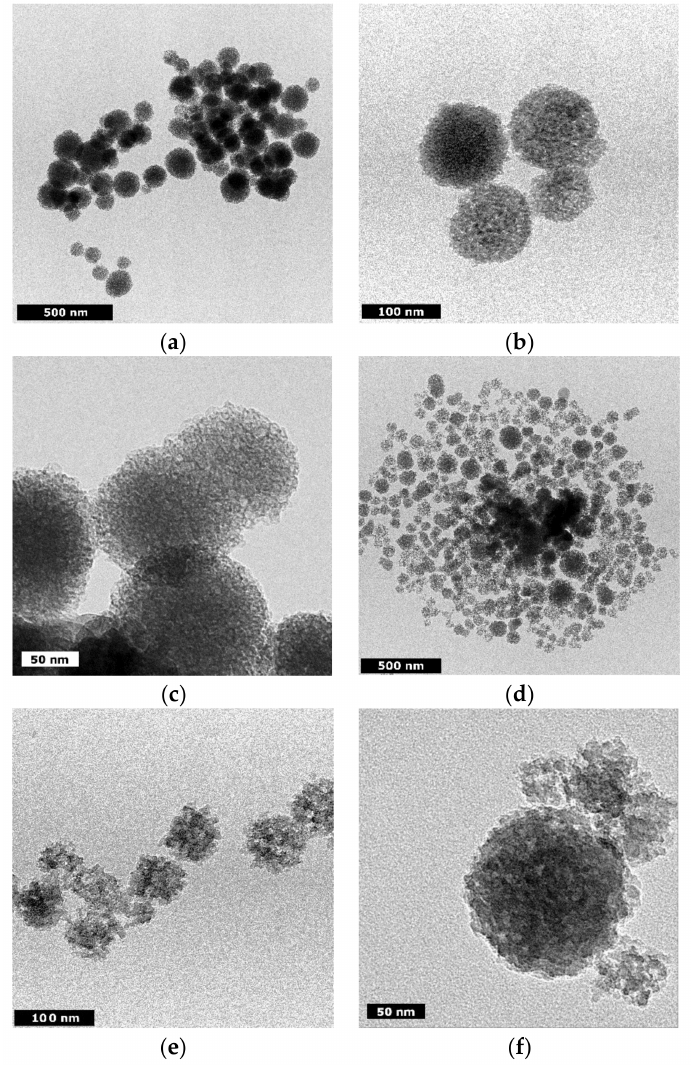
Figure 1. TEM micrographs of ( a – c ) bBG and ( d – f )